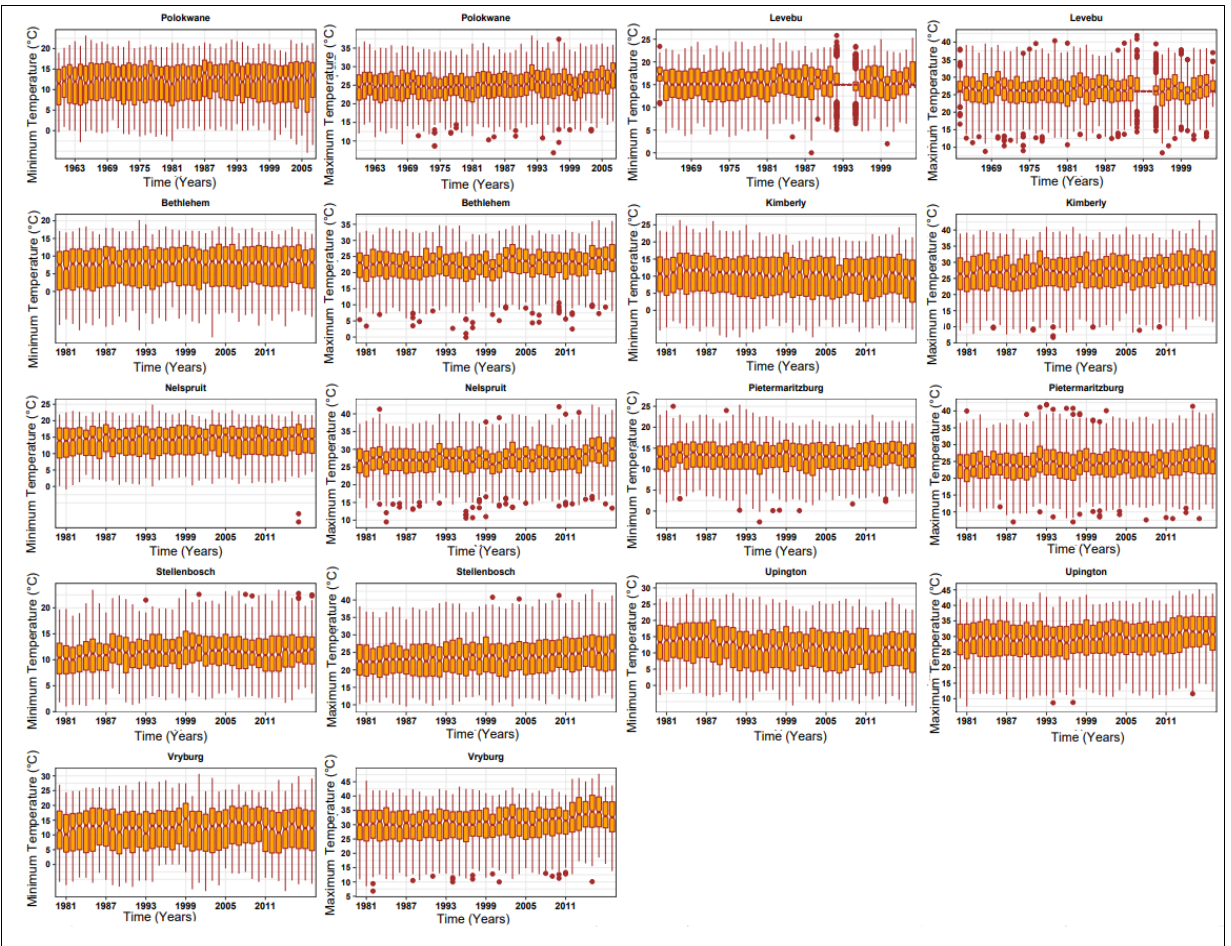
Figure 4. Minimum and maximum temperature trends at nine locations in South Africa over varying periods between 1960 and 2016.